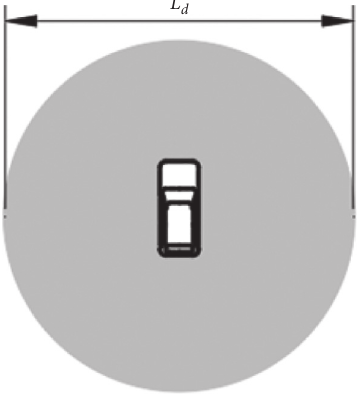
Figure 14: Original active regions.